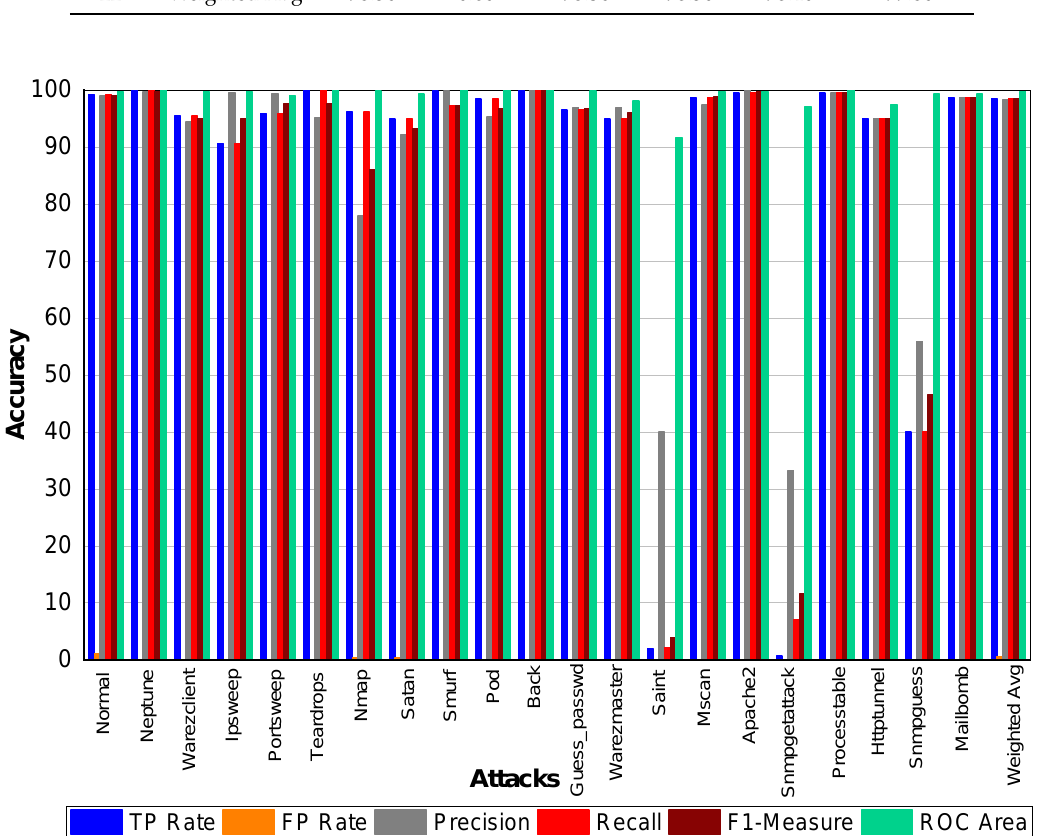
Figure 10. Classification report for the Adaboost Random Forest NSLKDD